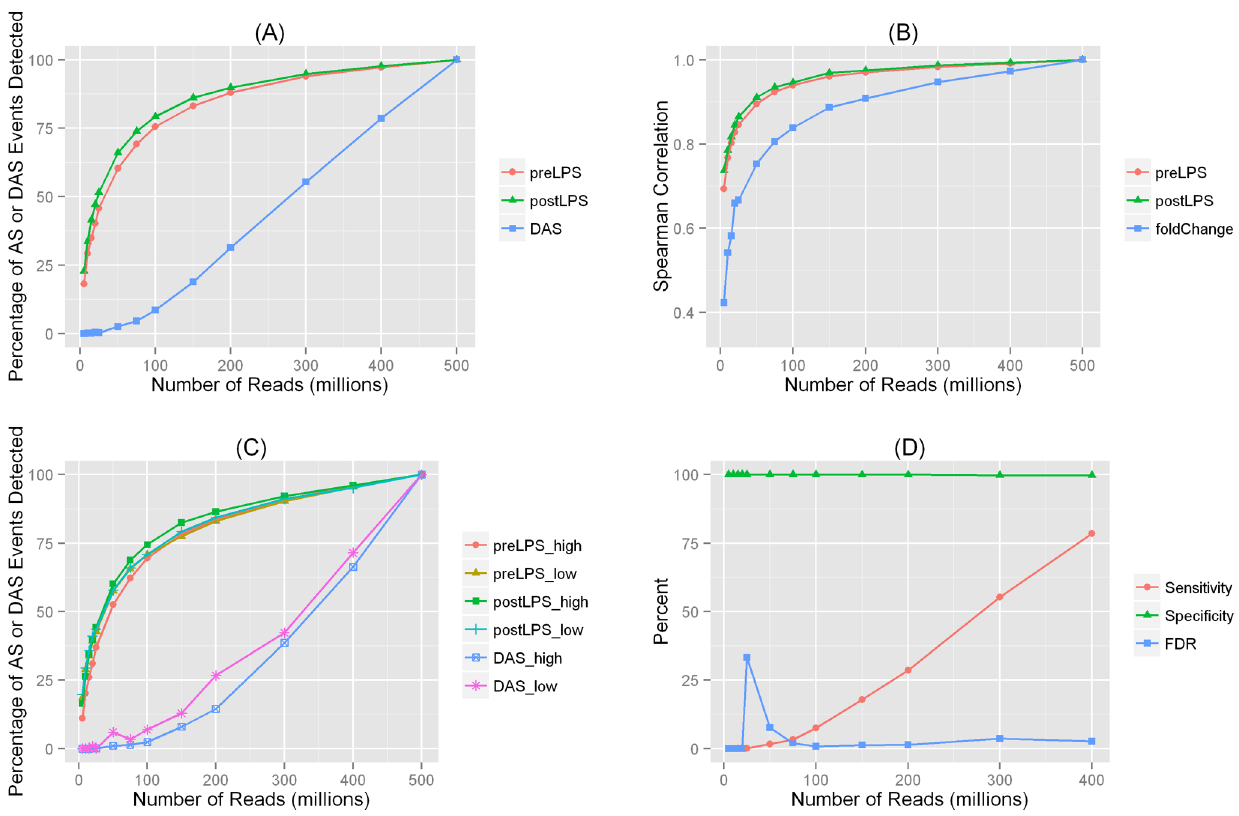
Figure 2. Analysis results for alternative splicing (AS) and differential AS (DAS) in adipose. ( A ) Percentage of detected alterantive splicing (AS) and differential AS (DAS) events for datasets with various sequencing depths. PreLPS: detection rate for AS events in the pre-LPS sample; postLPS: detection rate for AS events in the post-LPS sample; DAS: detection rate for DAS events. ( B ) Spearman correlation between exon or intron inclusion levels in datasets with various sequencing depths and inclusion levels in the 500 M-read datasets. PreLPS: correlation of inclusion levels in the pre-LPS sample; postLPS: correlation of inclusion levels in the post-LPS sample; fold-change: correlation of the fold change of isoform ratios. ( C ) Percentage of detected AS and DAS events according to gene expression levels. preLPS_high: detection rate for AS in highly expressed genes in the pre-LPS sample; preLPS_low: detection rate for AS in lowly expressed genes in the pre-LPS sample; postLPS_high: detection rate for AS in highly expressed genes in the post-LPS sample; postLPS_low: detection rate for AS in lowly expressed genes in the post-LPS sample; DAS_high: detection rate for DAS in highly expressed genes; DAS_low: detection rate for DAS in lowly expressed genes. ( D ) Performance of DAS events detected in datasets with various sequencing